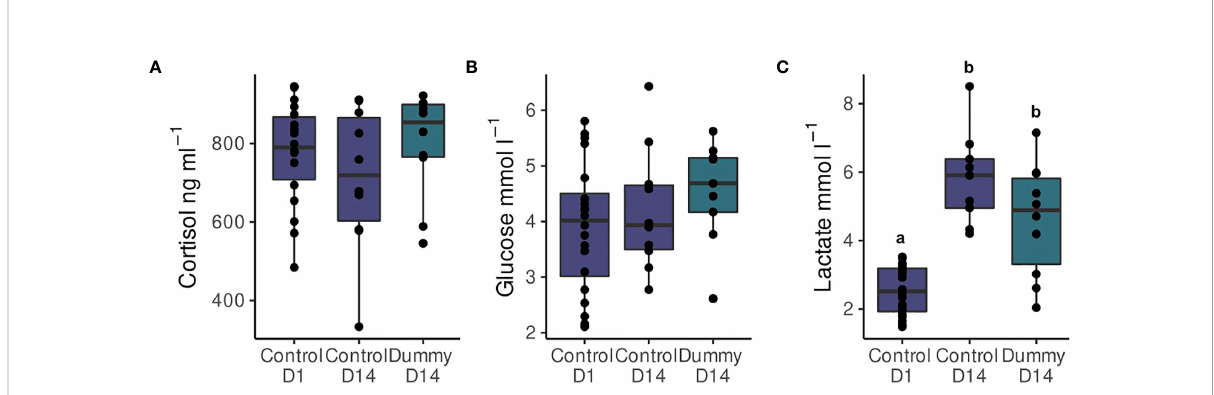
FIGURE 3 Plasma concentrations (mean ± SEM) of (A) cortisol, (B) glucose and (C) lactate of the control group in the 1st day (08 March 2021) and the control (N=25 fi sh) and dummy (N=20 fi sh) two weeks later (21 March 2021). Different letters indicate statistically signi fi cant differences between the groups (P<